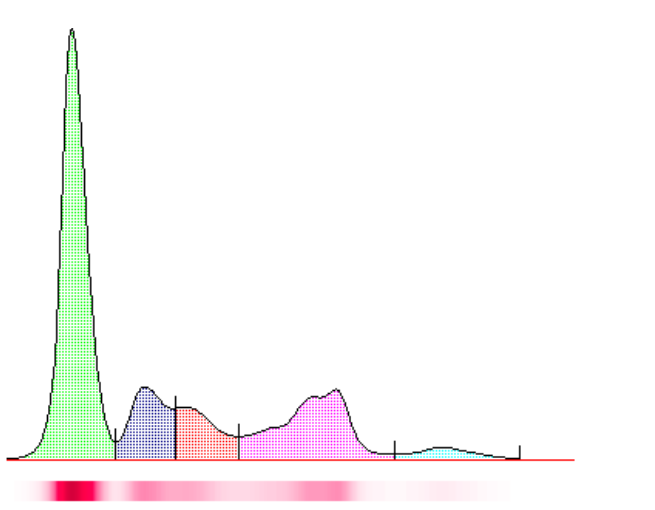
In Figure 2, an example of the electrophoretic pattern of a healthy E. europaeus individ- ual is presented. Medium values for each category are expressed in Table 2.